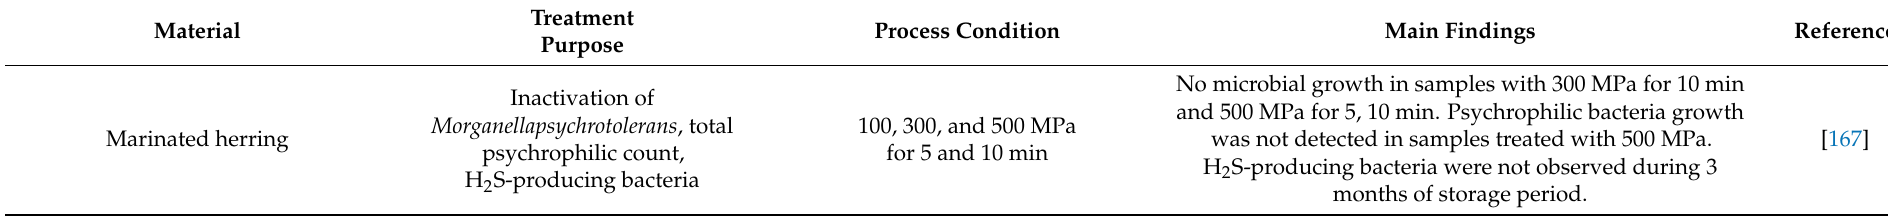
Table A2. Applications of HPP technology on various seafood